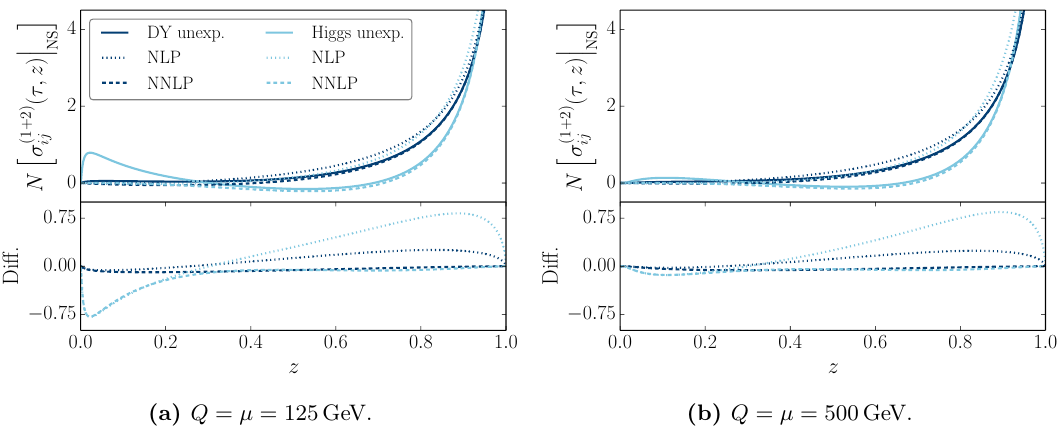
Figure 5. Exact (solid lines) as well as truncated expressions at NLP (dotted) and NNLP (dashed) for the non-singular part of the coefficient functions up to NNLO, weighted with the parton lumi- nosity, for the dominant channel of DY ( q ¯ q , dark blue) and single Higgs ( gg , light blue) production. All curves are normalized according to eq.